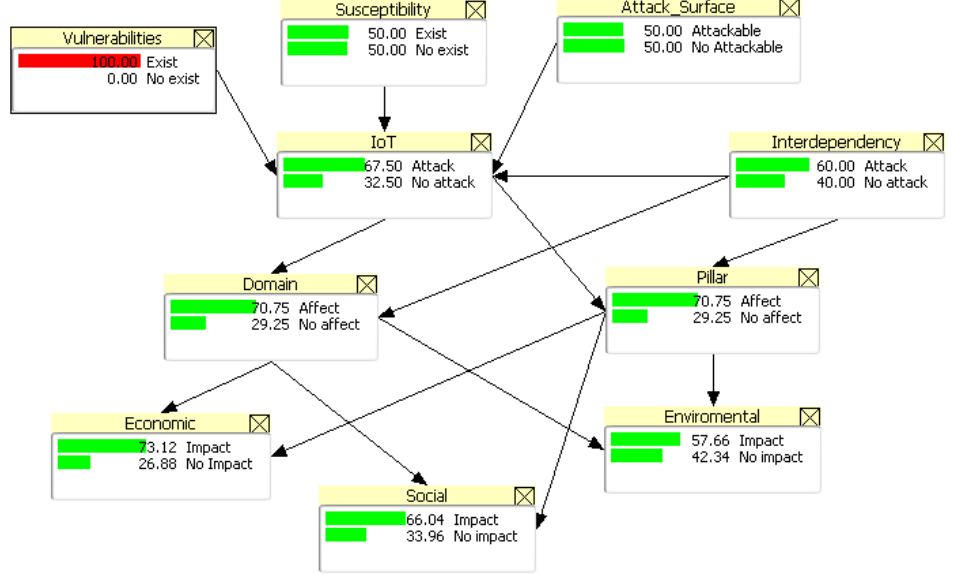
Figure 21. Calculation of the factors of IoT security risk based on the evidence of vulnerabilities.